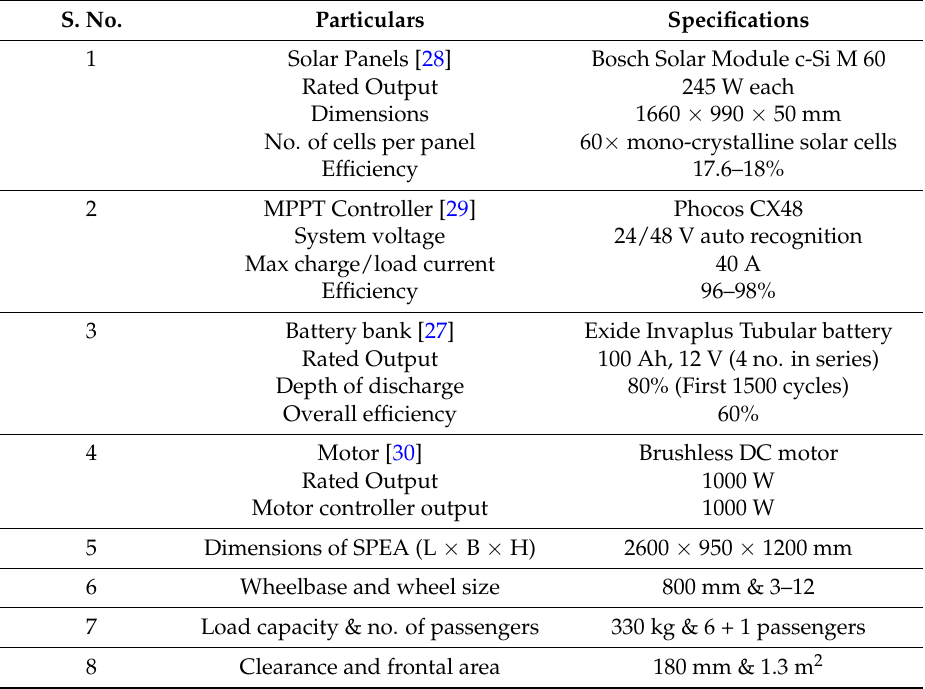
Table 1. Hardware specification of the SPEA